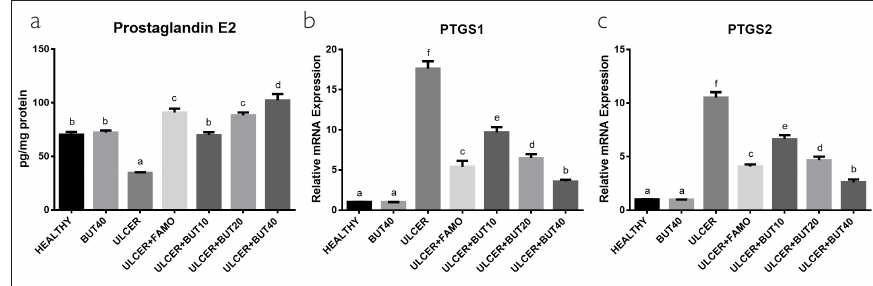
Figure 3. a-c. Stomach tissue PGE2 concentration (a) COX-1 (b) and COX-2 (c) mRNA expression. Means with the same letter are not significantly different; means with different letters indicate significant differences between the groups according to the Duncan test (p <0.05). Results are mean±SD. N=¼ 6 animals per group